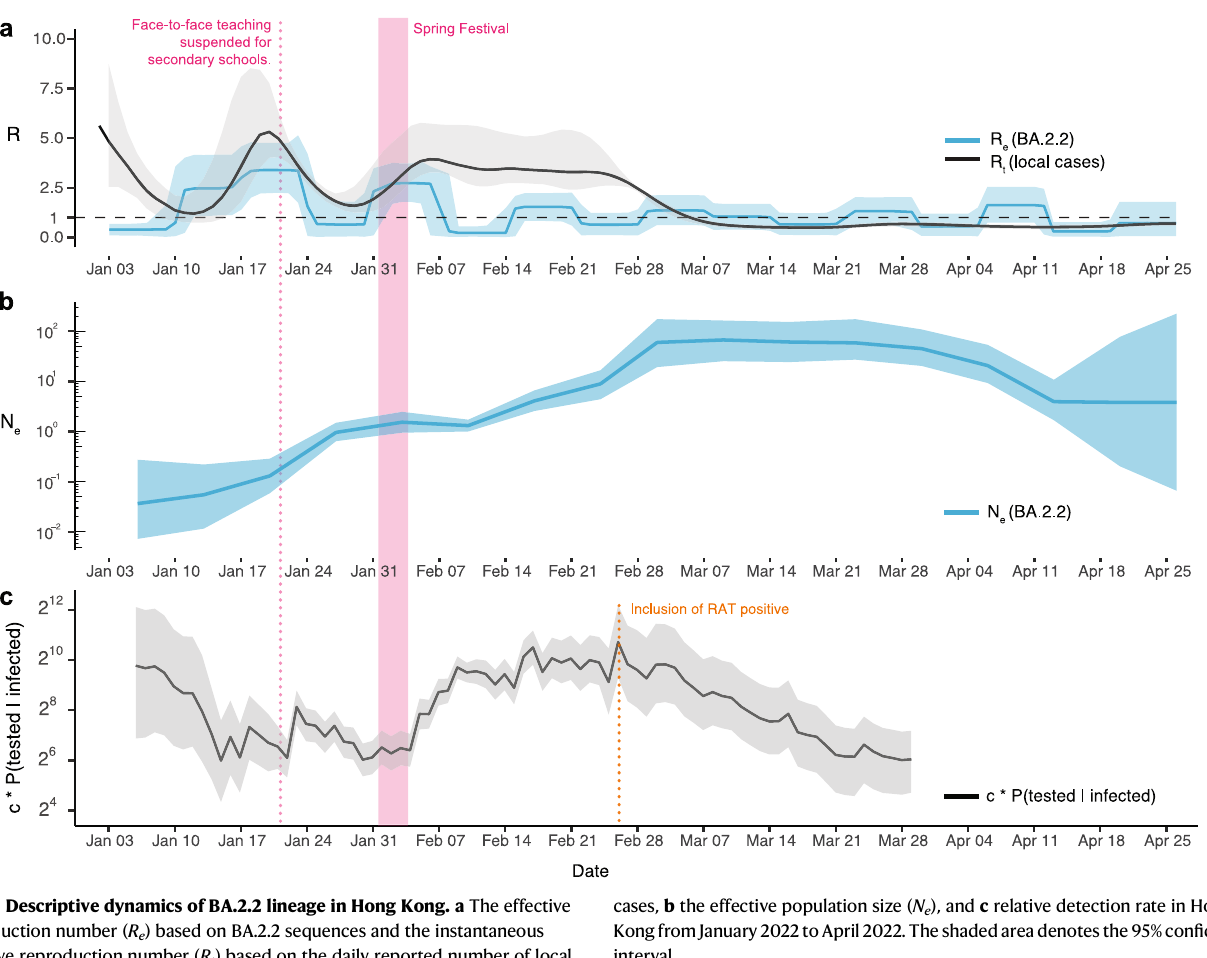
Fig. 3 | Descriptive dynamics of BA.2.2 lineage in Hong Kong. a The effective reproduction number ( R e ) based on BA.2.2 sequences and the instantaneous effective reproduction number ( R t ) based on the daily reported number of local